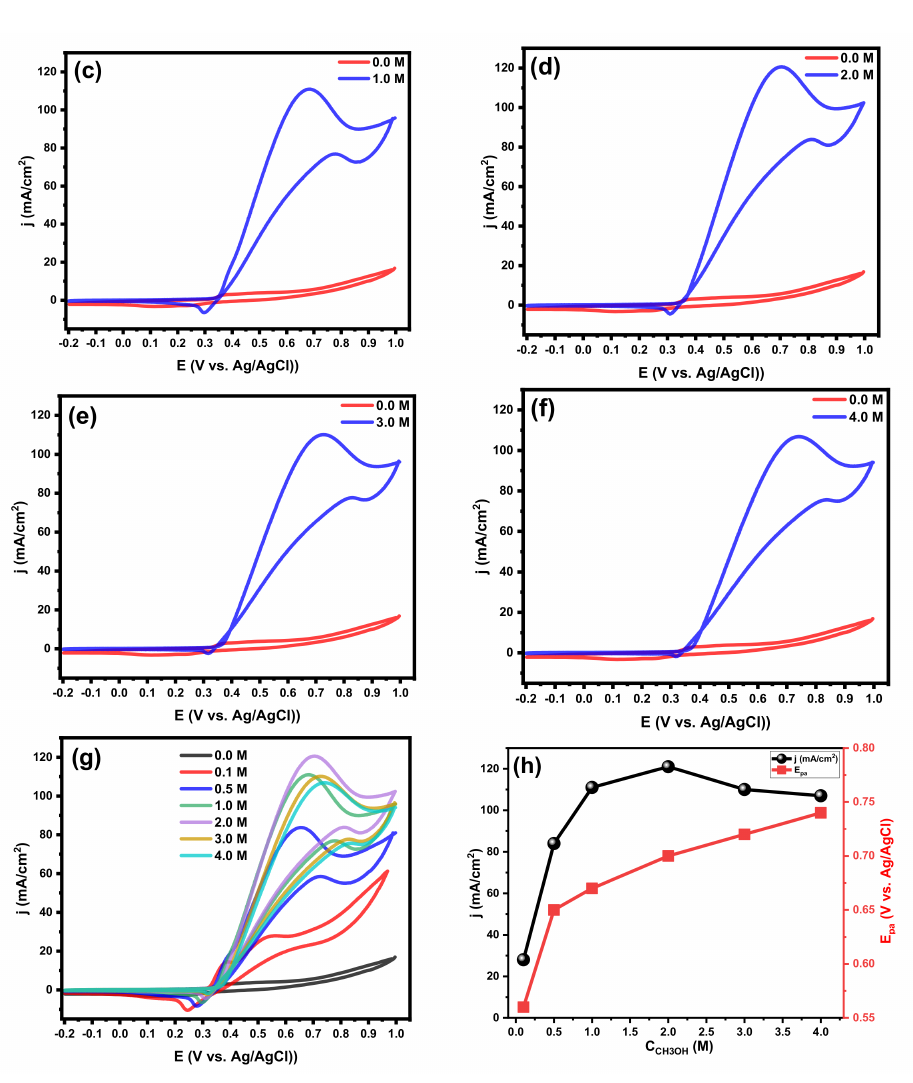
Figure 5. ( a – f ) CV curves of Ni NPs@PCFs catalyst in 1.0 M KOH + various CH 3 OH concentrations at a scan rate of 50 mV/s and ( h ) CH 3 OH concentration effect on E pa and current density.